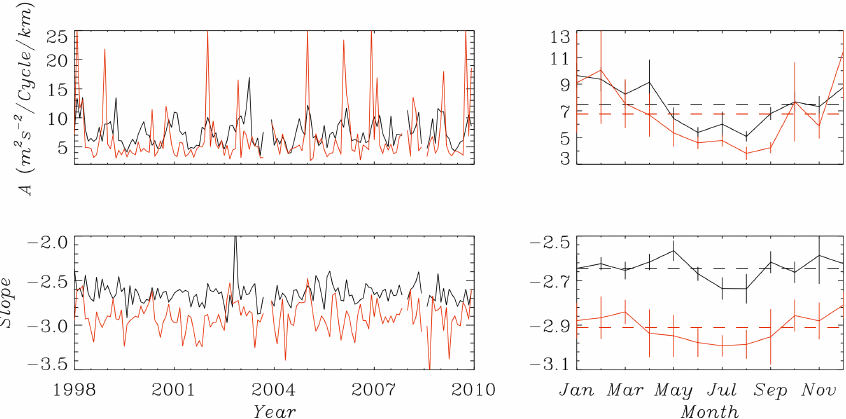
Figure 3. Monthly averaged (left panel) spectral amplitudes (upper panel) and slopes (bottom panel) of the zonal wind fluctuation. The gaps mean no measurements. The annual variations of these spectral parameters are illustrated in the right panel. The black and red curves denote, respectively, the spectral parameters in the troposphere and lower stratosphere. The horizontal and vertical lines in the right panel represent the mean values and standard deviations,